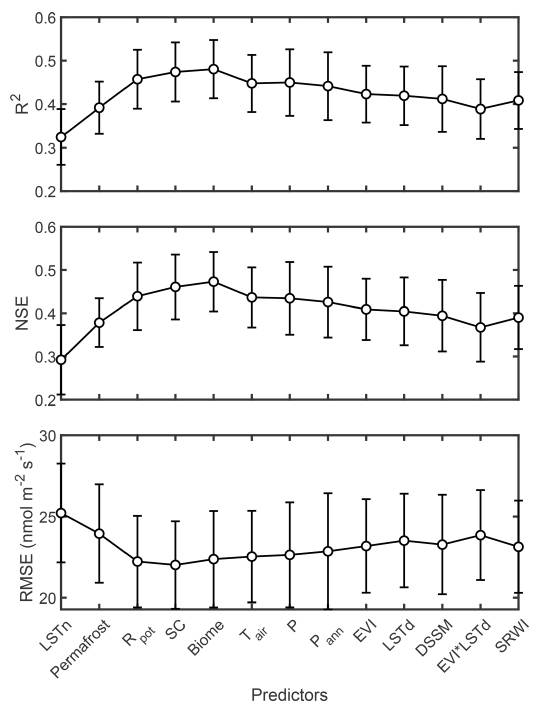
Figure 2. Evolution of statistical metrics during RF model devel- opment. Predictors were added to the RF model starting from the left of the figure and accumulate along the x axis. For instance, the x tick label “SC” shows the RF model performance when LSTn, Permafrost, Rpot and SC were used as predictors in the model. See the x tick label explanations in Table 1. The error bars denote 1 σ uncertainty of the values estimated with